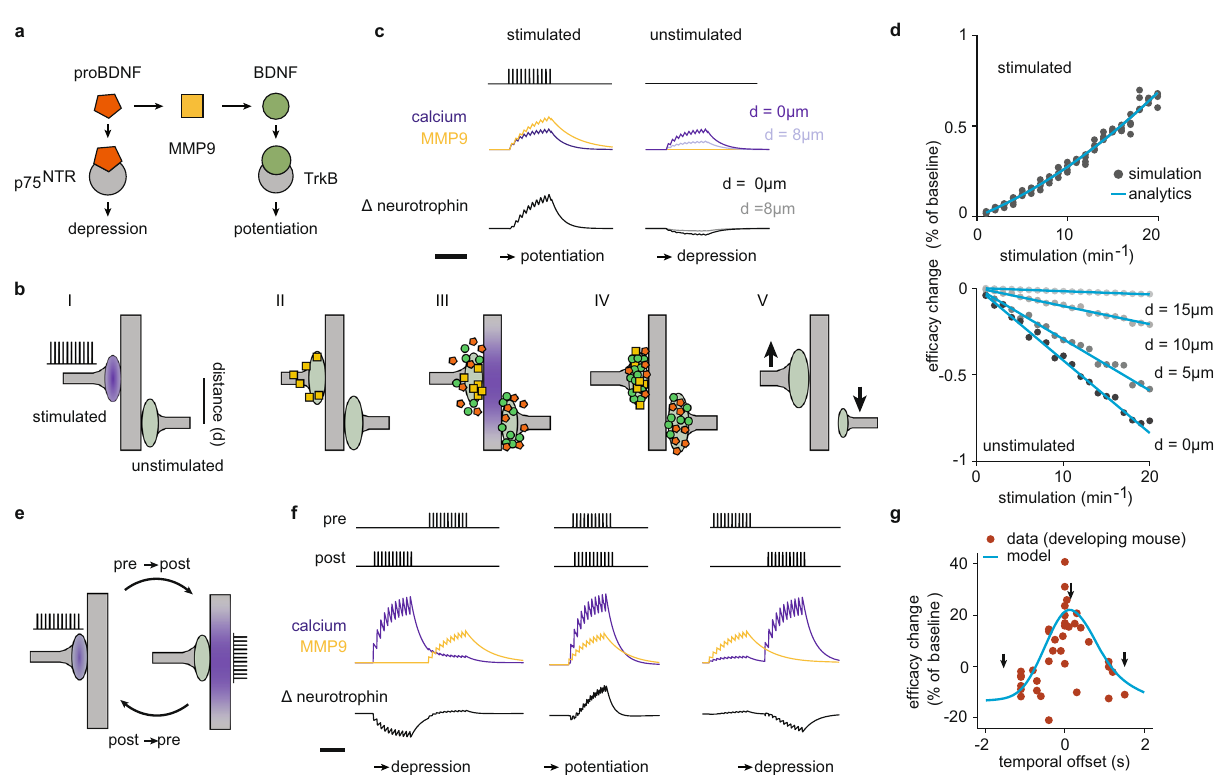
Fig. 1 Distance- and timing-dependent synaptic competition in the neurotrophin model. a Model schematic: interactions between neurotrophins (BDNF and proBDNF), neurotrophin receptors (TrkB and P75 NTR ), and cleaving protease (MMP9). b Outcome of synaptic stimulation where two synapses separated by a distance d innervate the same dendrite: I. The left synapse is stimulated with a burst of action potentials. II. Presynaptic activation causes the local release of MMP9 (yellow). III. Signal transduction into the postsynapse results in the spatially extended in fl ux of calcium (purple shading). Calcium triggers the exocytosis of proBDNF (orange) and BDNF (green) into extracellular space. IV. MMP9 differentially cleaves proBDNF into BDNF at the stimulated synapse. V. Repeating this pattern of stimulation potentiates the stimulated synapse and depresses the unstimulated synapse (arrows). Symbols as in a . c Variables (all unitless, see Methods) in a upon stimulation of one synapse only; the unstimulated synapse is distance d away, as in b . Δ neurotrophin is the difference between BDNF and proBDNF. Scale bar is 1 s. d Percentage change in synaptic ef fi cacy (of baseline) of the stimulated synapse (top) and the unstimulated synapse (bottom) as a function of input rate (in bursts per minute, after 1 min of continuous stimulation) and distance d . The analytical solution follows from a linearized version of the model (see Methods). e A burst-timing-dependent plasticity induction protocol where the temporal offset between pre- and postsynaptic bursts is varied 27 . A single synapse innervates the dendrite. Purple shading indicates either pre- (left) or postsynaptic (right) activation. f Accumulator and neurotrophin variables under the burst pairing protocol with temporal offsets − 1.5 s (left), 0.05 s (middle), and 1.5 s (right). Scale bar is 0.5 s. We assumed that the calcium from direct postsynaptic stimulation is stronger than that released by stimulation of a synapse (compare to c and see Methods). g Percentage change in synaptic ef fi cacy (of baseline) as a function of temporal offset (data repesent change in EPSP size from developing mouse LGN reproduced from ref. 27 ). The arrows mark the temporal offsets displayed in f